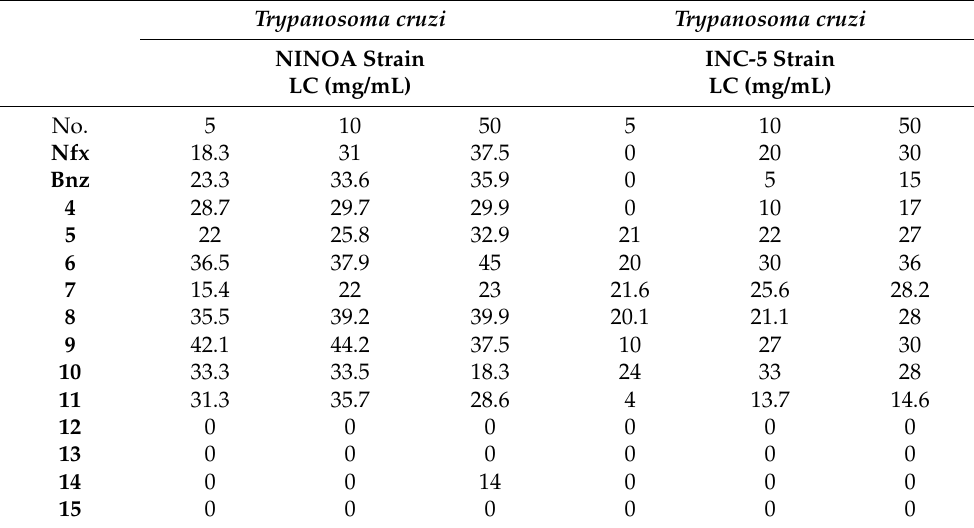
Table 2. In vitro activity of 4 – 15 against bloodstream trypomastigote of T. cruzi. Trypanosoma cruzi Trypanosoma